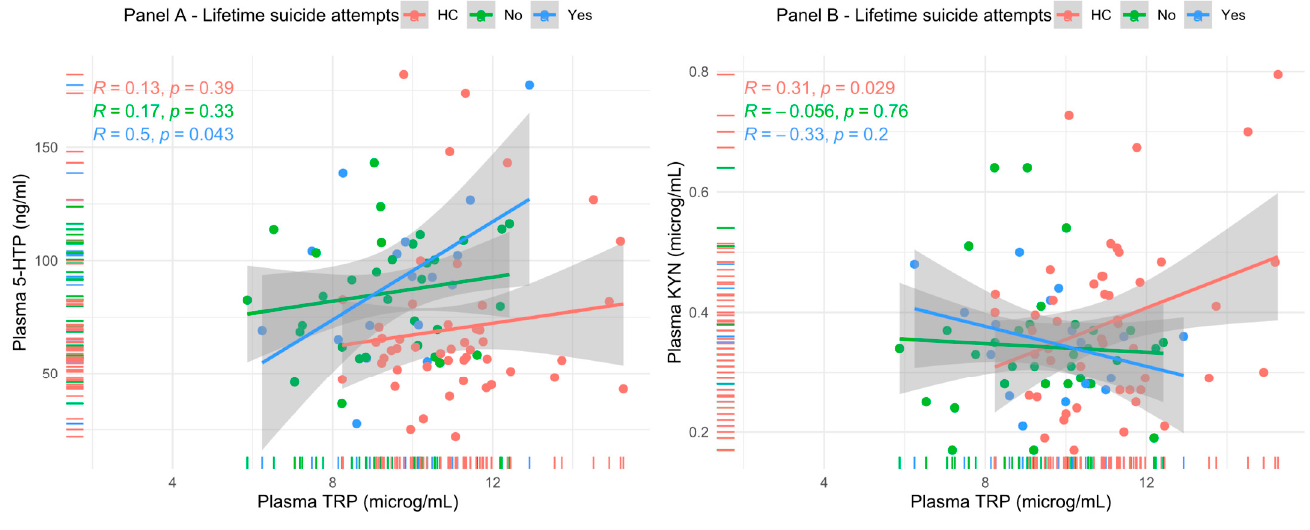
Figure 2. Relationship between plasma TRP and two of its major metabolites, 5-HTP and KYN.